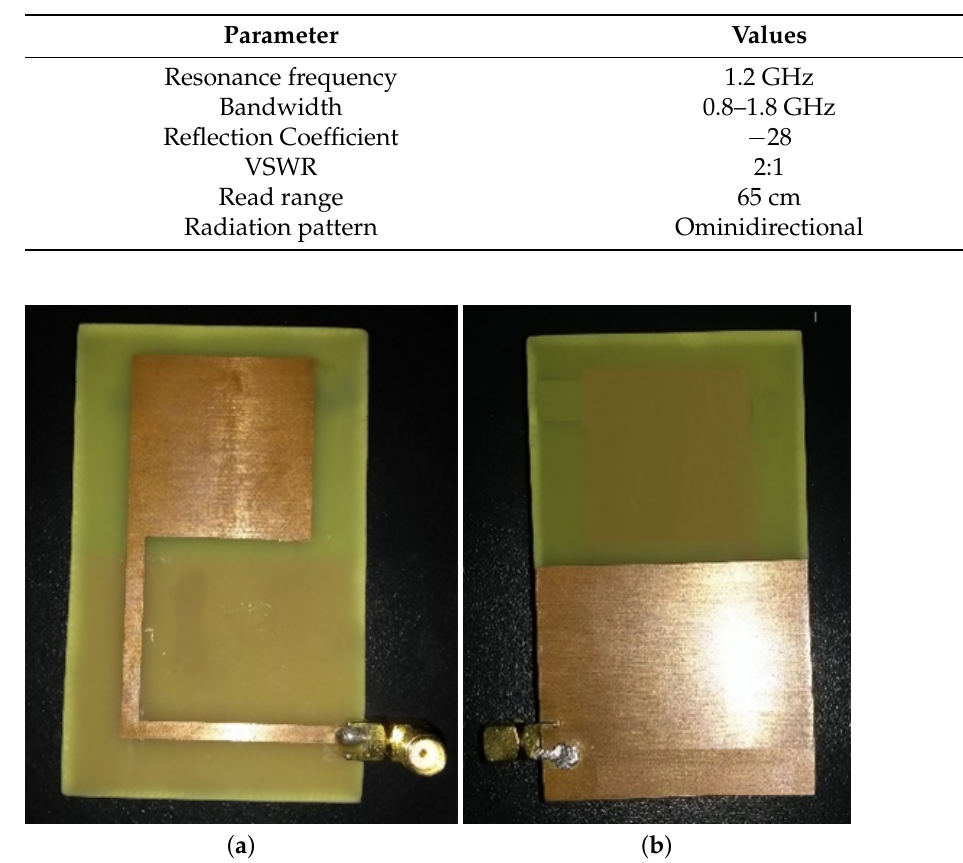
Figure 9. Fabricated prototype of omnidirectional wide band antenna on FR-4 epoxy ( a ) Top view ( b ) Bottom